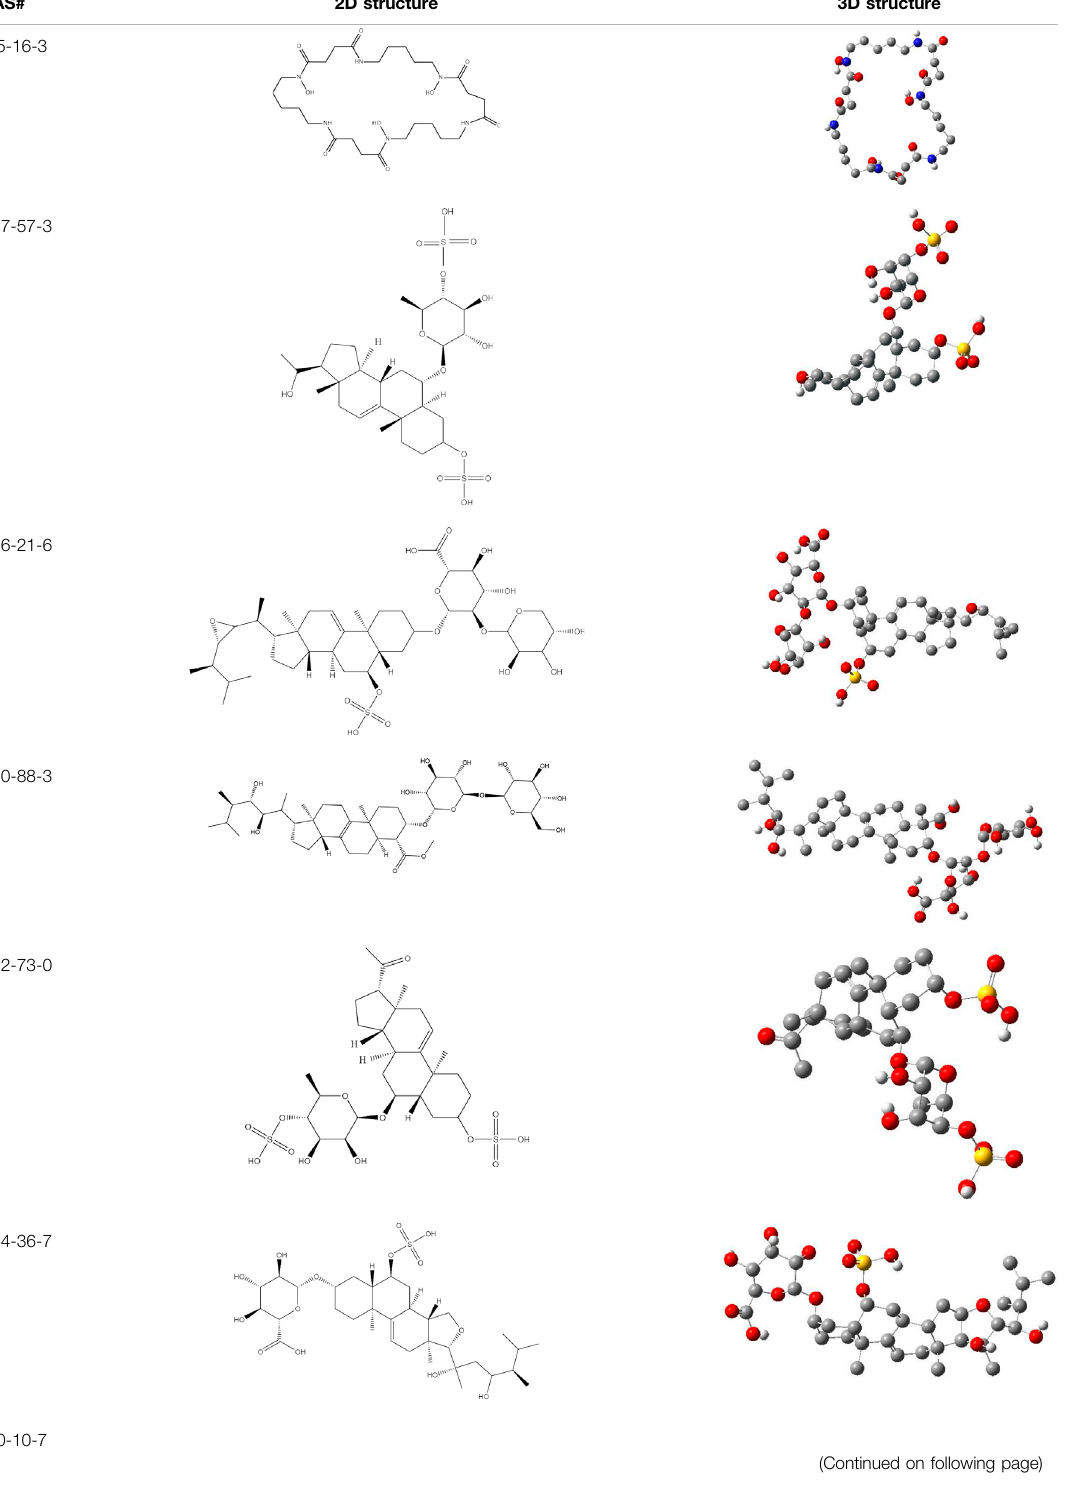
TABLE 3 | CAS number, 2D and 3D presentations of investigated marine natural